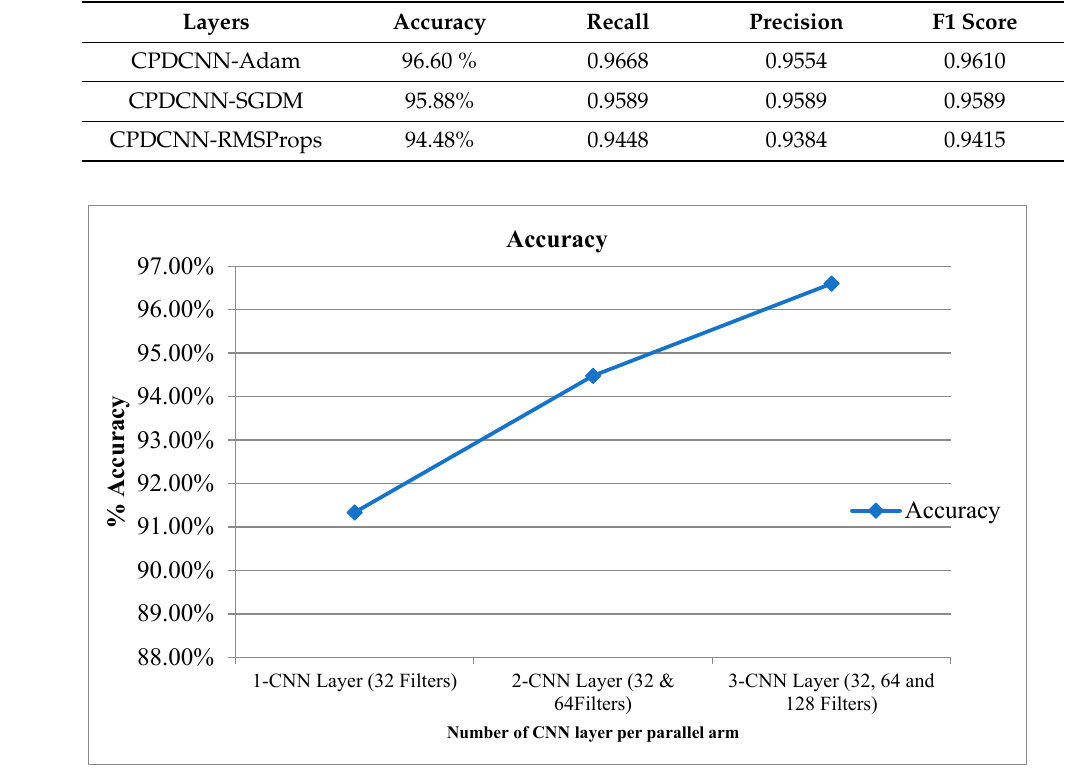
Figure 4. Accuracy for proposed CPDCNN for various layers.